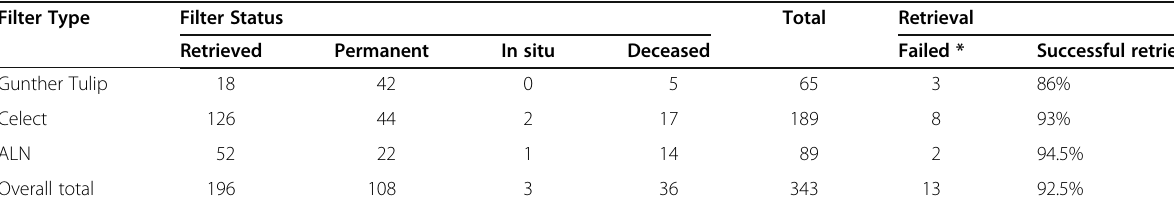
Table 3 Retrieval Rate by Filter Type ( n = 343) Filter